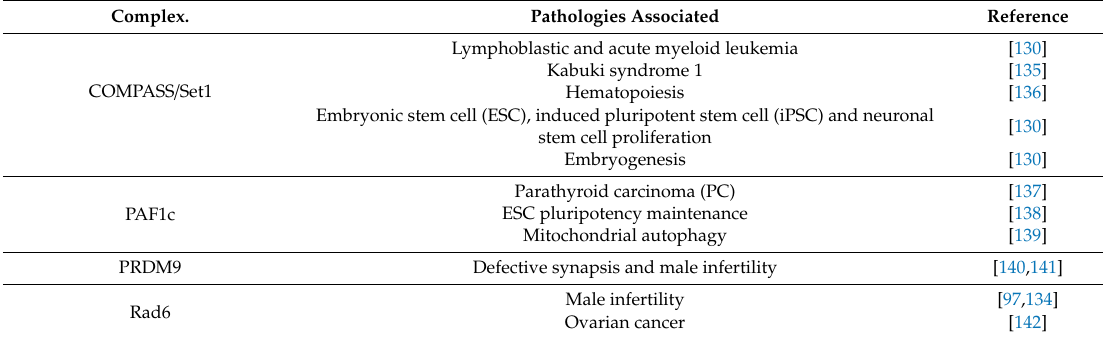
Table 1. List of some human diseases associated to machineries involved in H3K4me3 and H2Bub.